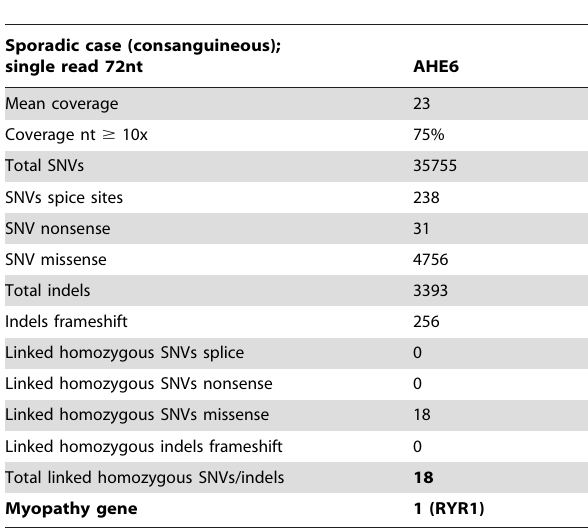
Table 5. Statistical overview of the exome sequencing results: sporadic case (consanguineous)